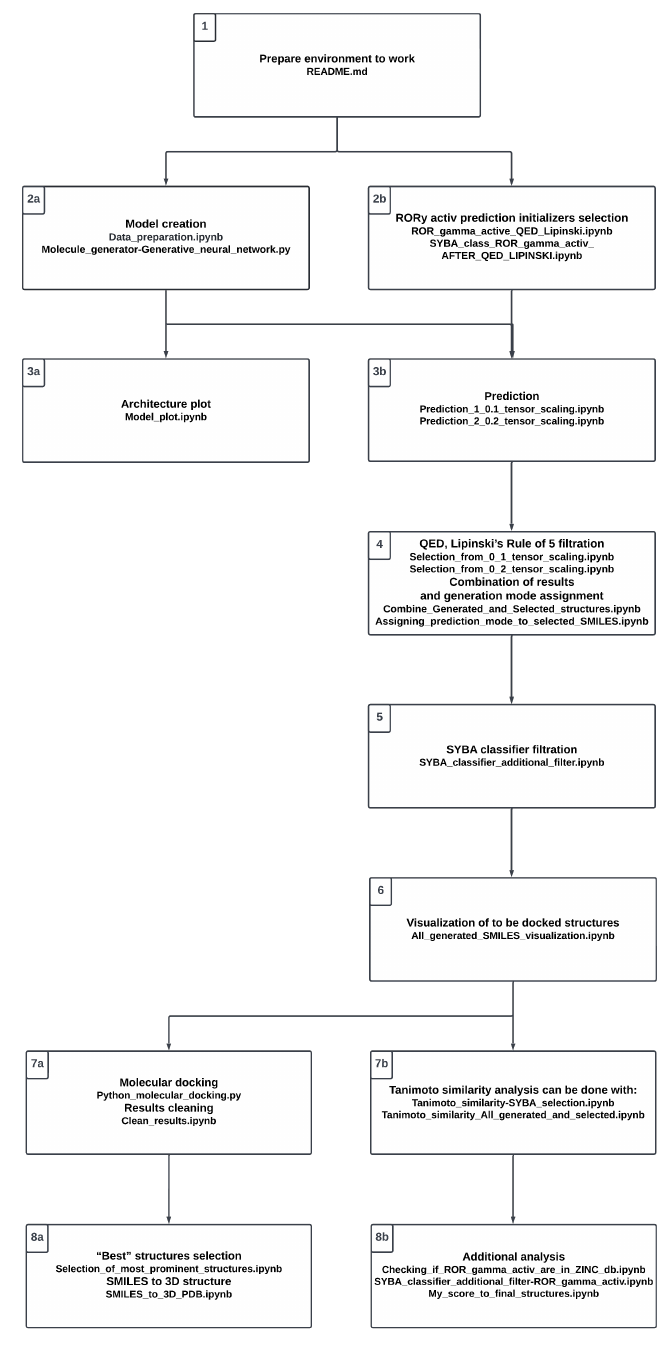
Figure 3. The flowchart of the overall